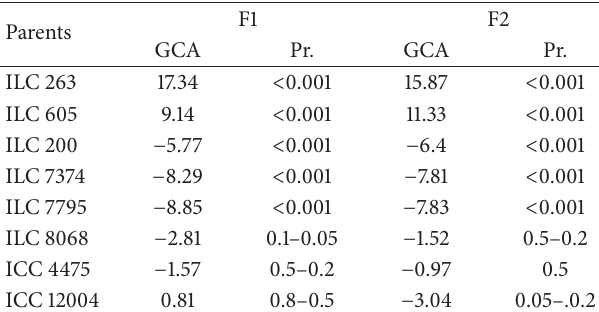
Table 7: GCA value of 8 parents at the seedling stage of F1. Table 8: Variance of combining ability estimates and component of